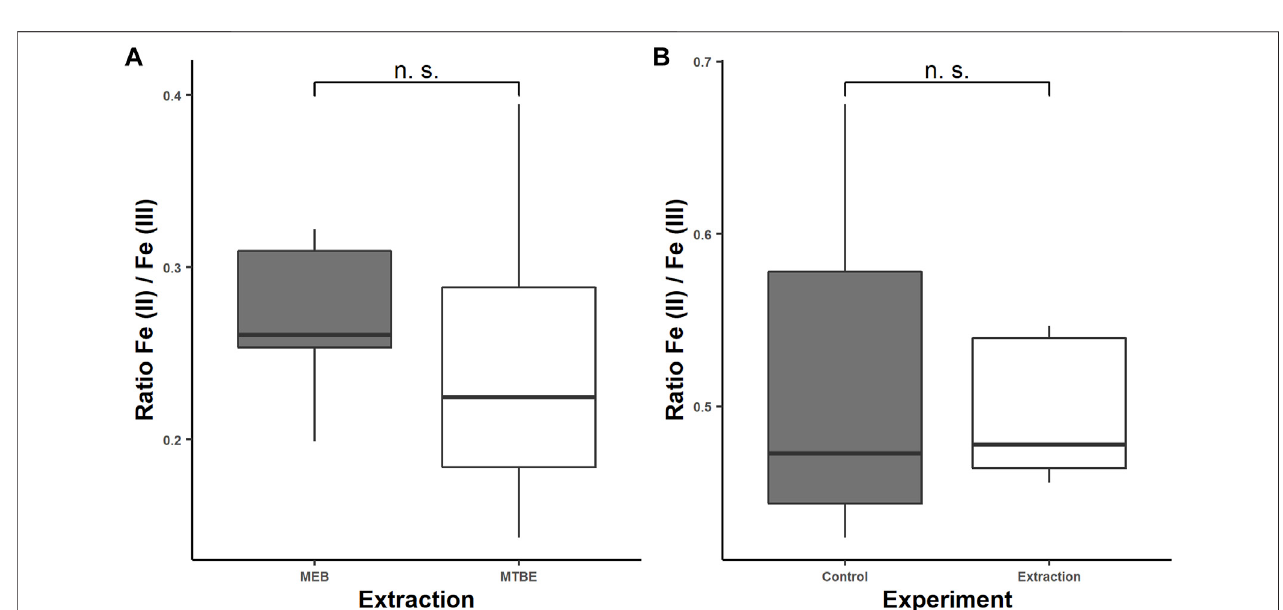
FIGURE 4 | Fe (II)/Fe (III) ratios for the modi fi ed extraction protocol with and without traces of methyl-tert-butyl ether (MTBE) to study the effect of MTBE/MeOH on the iron redox state equilibrium (A) and Fe (II)/Fe (III) ratiosfor a 5-mg/L Fe (II) and Fe (III) standard solution in the MEB after following the extraction protocol compared to the standard solution (B) . The determination was carried out by CE –